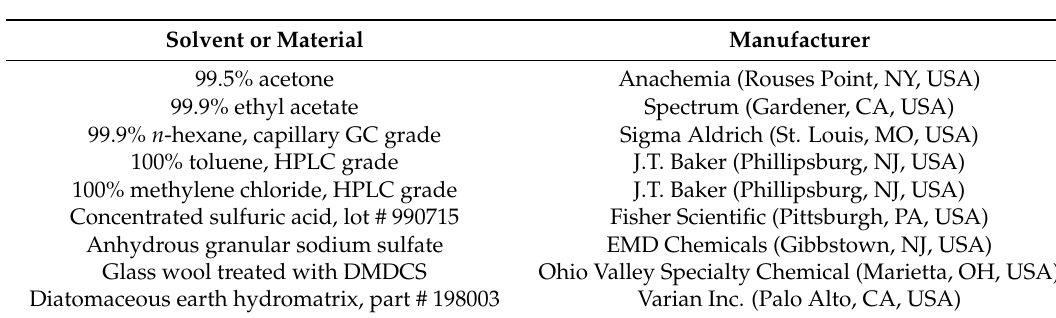
Table 2. Solvents and Materials.